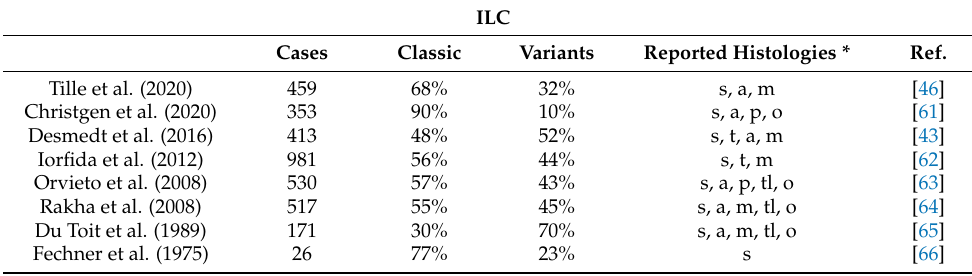
Table A4. Proportion of ILC variants.